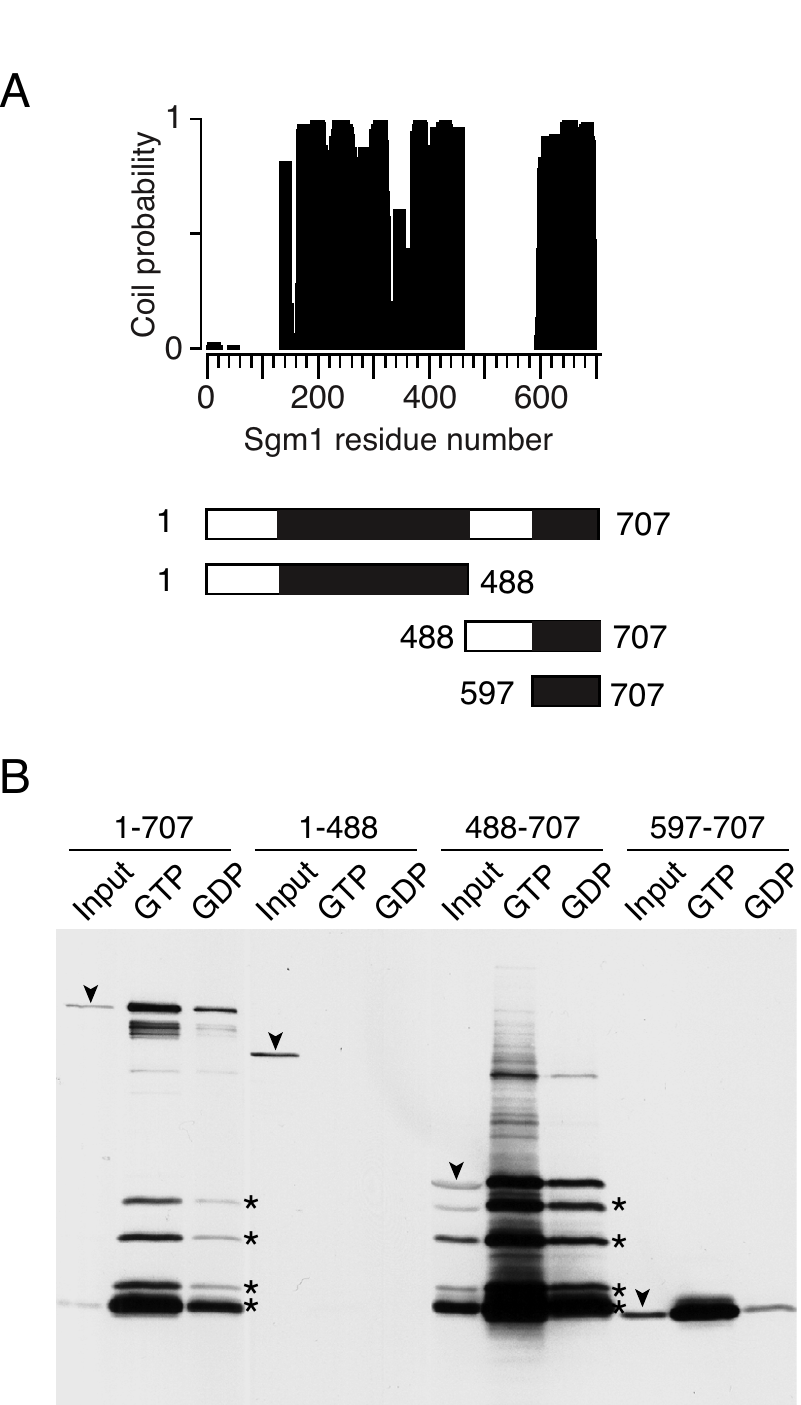
Figure 1 Mapping the Ypt6 binding site on Sgm1 A. Coiled-coil probabilities of the Sgm1 protein sequence, calculated by the method of Lupas using the coils program. The regions analysed for binding are shown diagrammatically below. B. Immunoblot with anti-Protein A of the indicated portions of Sgm1 bound to and eluted from GST-Ypt6 in the GTP and GDP state. Input samples are yeast extract corresponding to about 1% of the total input. The intact protein A fusions are indicated by the arrowheads. Asterisks mark C terminal proteolytic fragments, still fused to protein A, that are common to both the full-length and 488–707 constructs; note that the smallest visible fragment corresponds closely to the 597–707 construct. Proteins appar- ently larger than the input in the 488–707 lanes presumably represent dimers and other